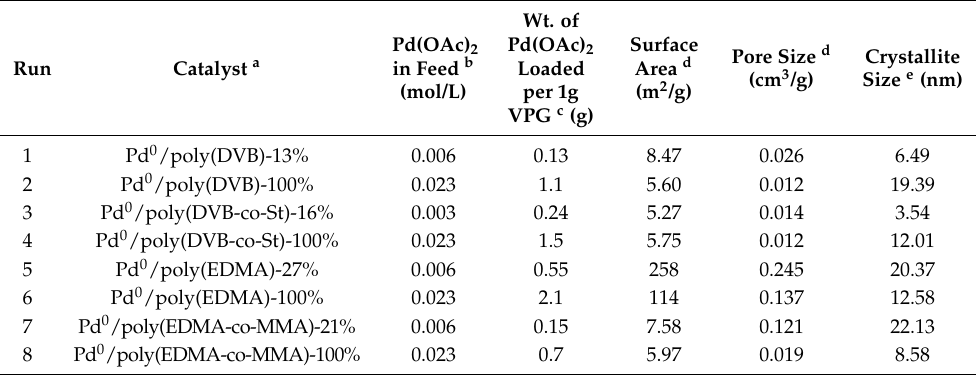
Figure 4. XRD profiles of ( a ) Pd 0 sample prepared in the absence of VPG; ( b ) Pd 0 /poly(EDMA)- 100%; ( c ) Pd 0 /poly(EDMA)-27%; ( d ) Pd 0 /poly(EDMA-co-MMA)-100%; ( e ) Pd 0 /poly(EDMA-co- MMA)-21%; ( f ) Pd 0 /poly(DVB)-100%; ( g ) Pd 0 /poly(DVB)-13%; (h) Pd 0 /poly(DVB-co-St)-100%; (i) Pd 0 /poly(DVB-co-St)-16%. Table 2. Surface area, pore volume and crystallite size of palladium(0) nanoparticles supported on polymer